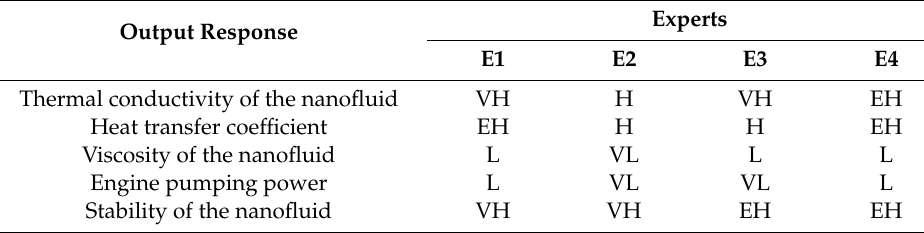
Table 7. Importance of output responses.